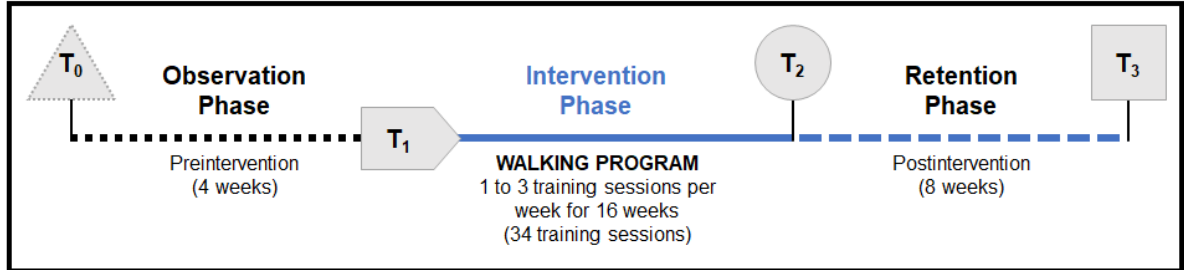
Figure 2. Summary of the design of the study along with the different assessment times. T 0 : control measurement time; T 1 : preintervention measurement time; T 2 : postintervention measurement time; T 3 : retention measurement